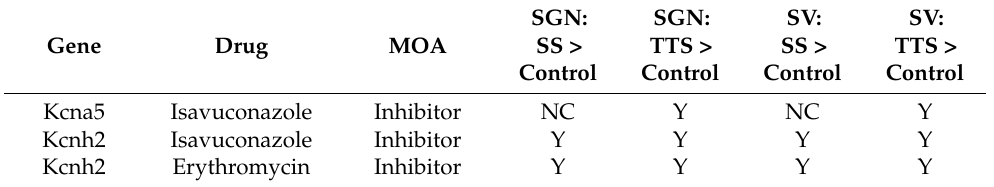
Table 8. FDA approved, orally administered antifungal and antibiotics that interact with steroid- responsive genes in the cochlea localized to SGN and SV cell types.